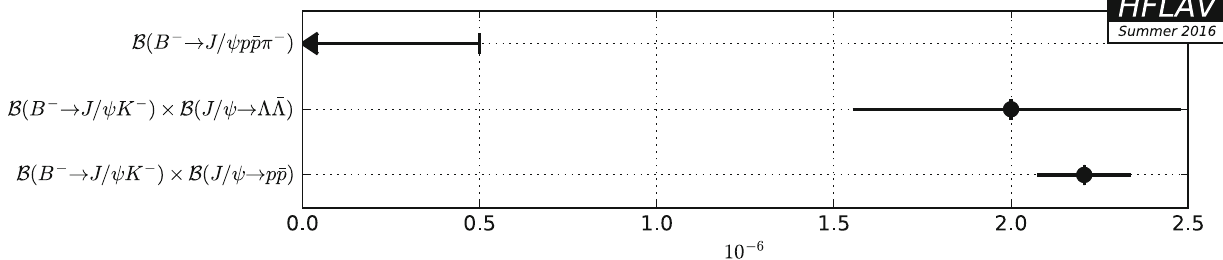
Fig. 136 Summary of the averages from Table 167